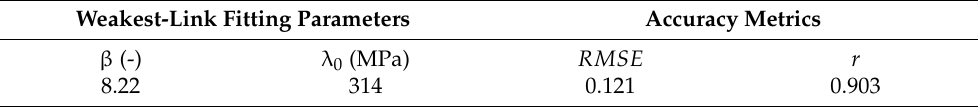
Table 3. Fitting parameters and accuracy